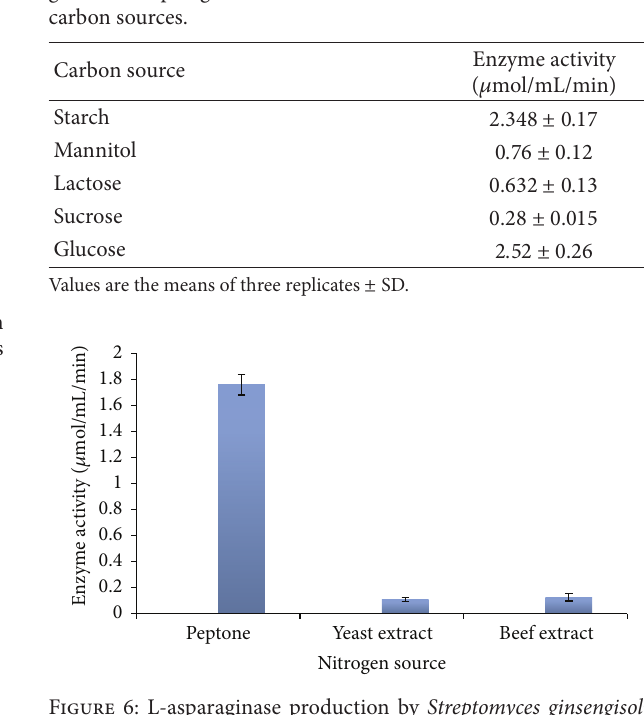
Table 3: L-asparaginase production by Streptomyces ginsengisoli